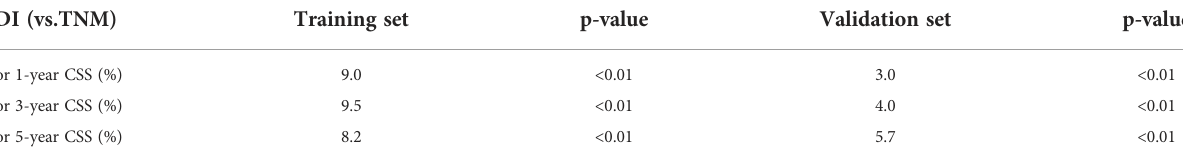
TABLE 4 IDI of the nomogram in survival prediction for mccRCC patients compared with TNM staging.